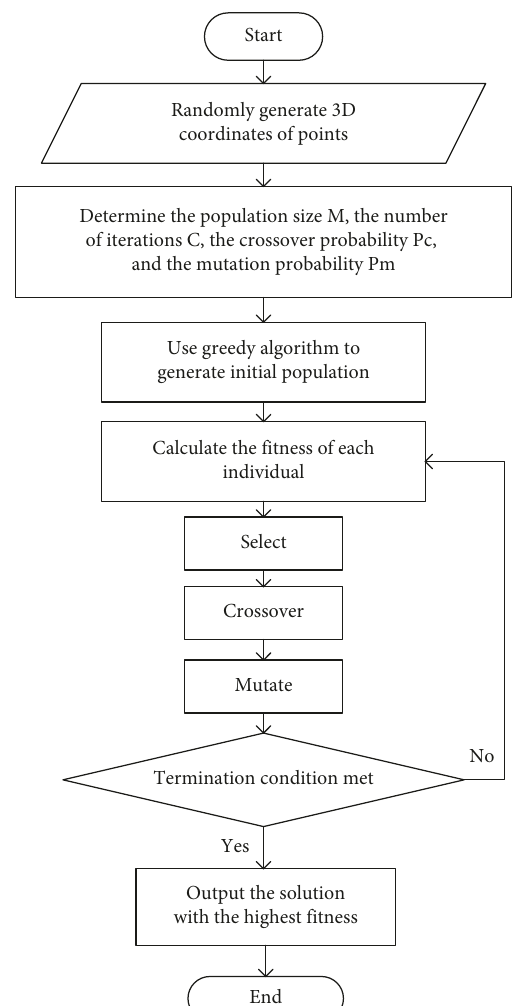
Figure 1: Flowchart of the improved GA for the population initialization.